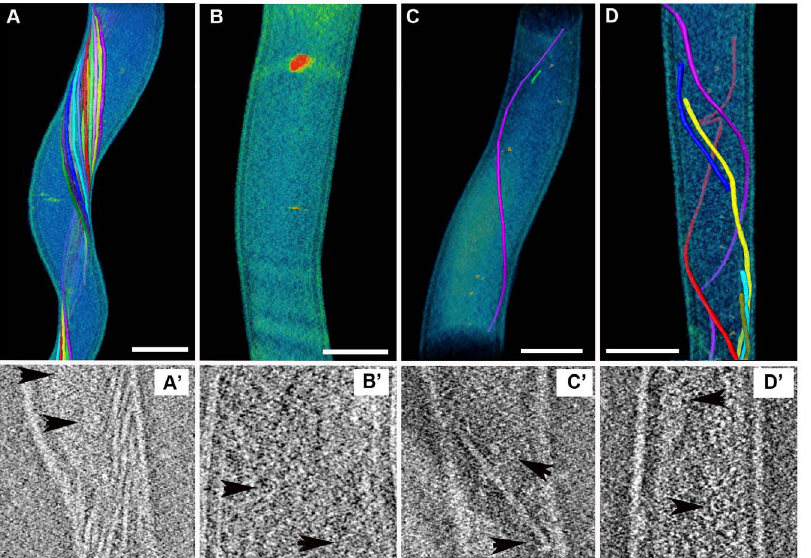
Figure 3. Electron microscope analysis of intact B. hermsii cells for the presence of periplasmic flagella. (A–D) 3-dimensional tomographic renderings of B. hermsii wild-type and mutant cells. The wild-type cell has numerous intact axial filaments each delineated by different colors (A), while the three mutant cells show either no (B), one intact (C), or several irregular and truncated filaments. (D). Ortho-slice views (A 9 –D 9 ) taken from the same respective samples show the presence of basal bodies (black arrowheads) including the mutant cell lacking axial filaments (B & B 9 ). The scale bar represents 0.2 m m.